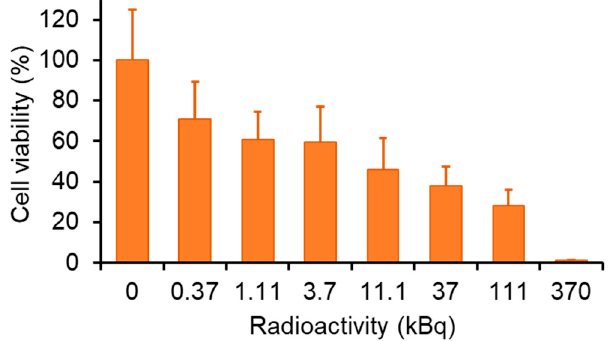
Figure 4. Cytotoxicity assay. The cytotoxicity of [ 125 I] 5 toward Colon 26 cells. Data are presented as mean ± SD for 3–9 samples.